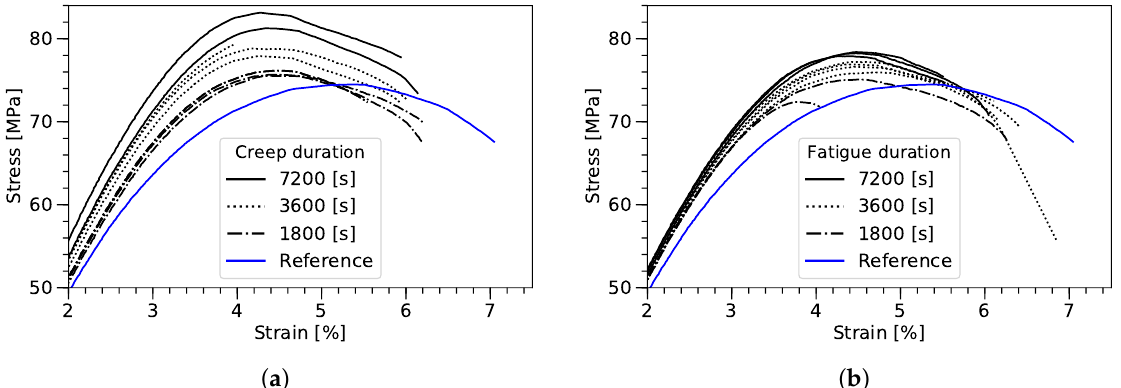
Figure 6. Tensile tests showing the residual strength after creep ( a ) and fatigue loading ( b ), a stress of 43 MPa at 50 ◦ has been